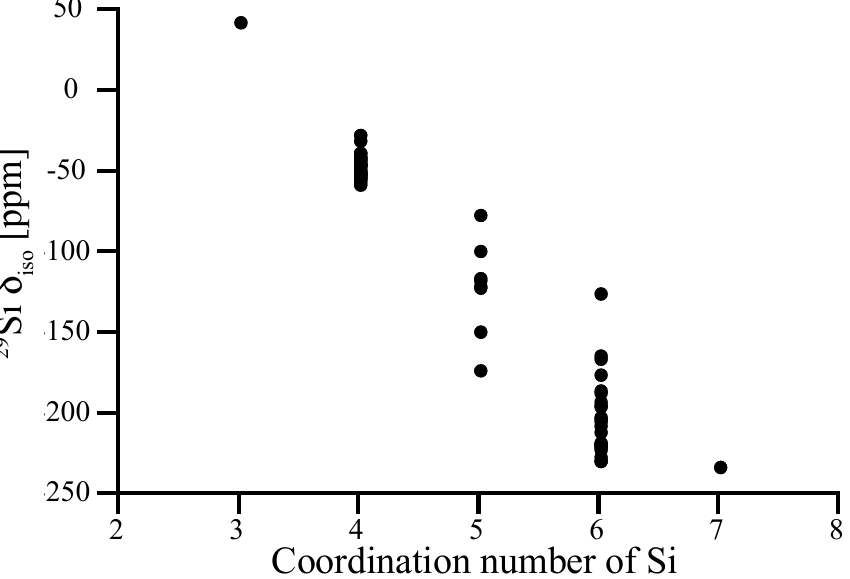
Figure 2. Relation between experimental data and computed absolute 29 Si NMR chemical shifts of Si sites in a variety of crystalline silicon nitrides. The calibration curve is a linear fit (unit slope) to the data.